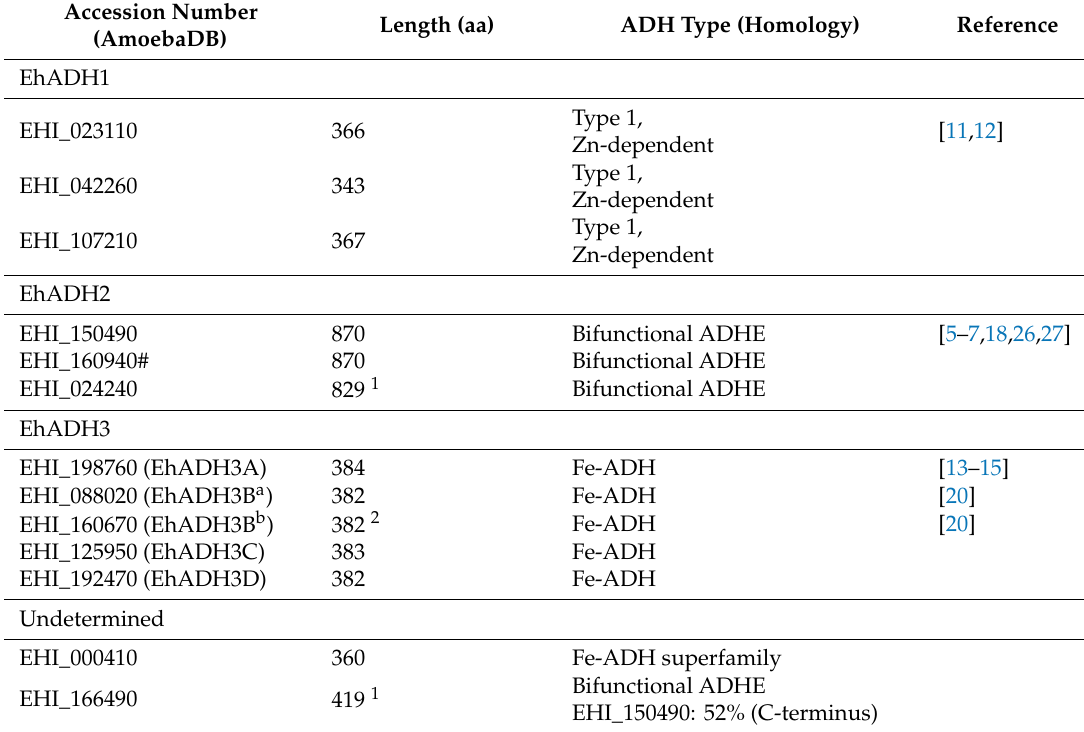
Table 1. Alcohol dehydrogenases of Entamoeba